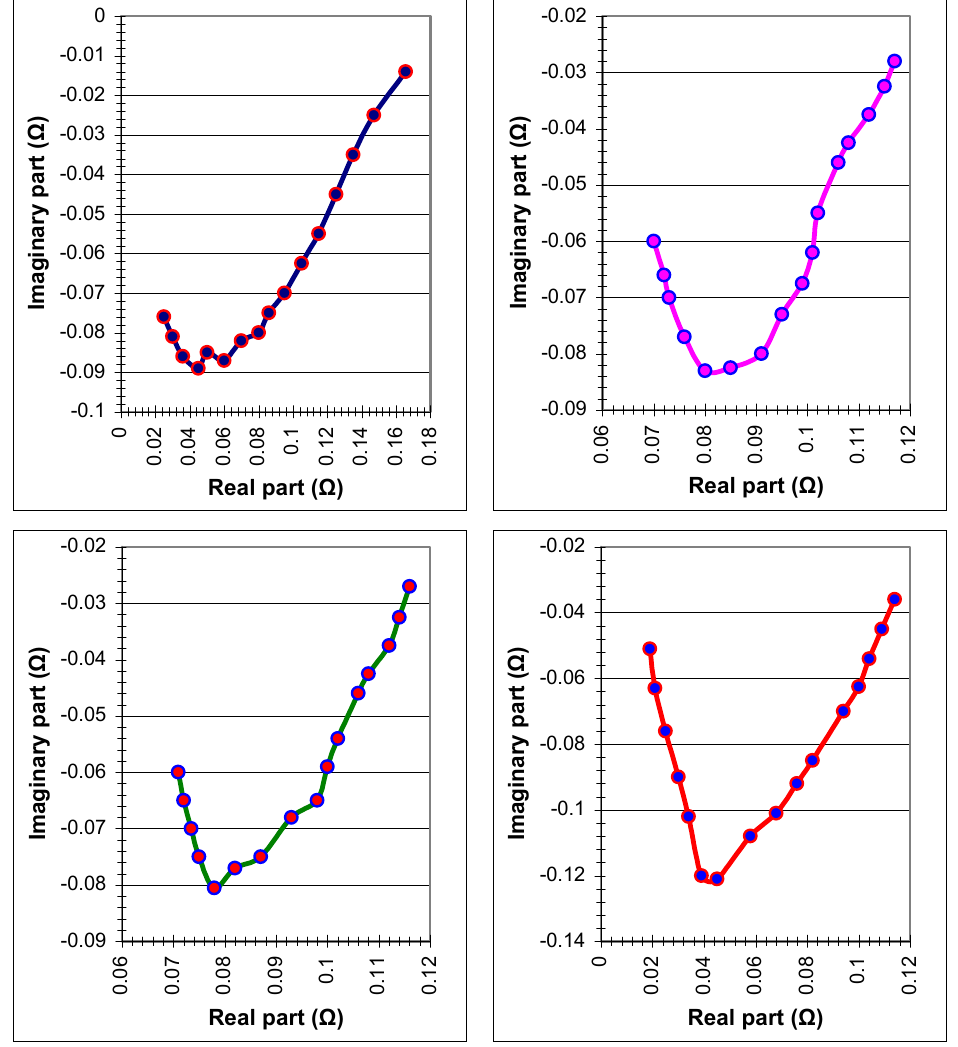
Figure 15. Impedance of the battery at an imposed current of 0.6A and at nominal voltage